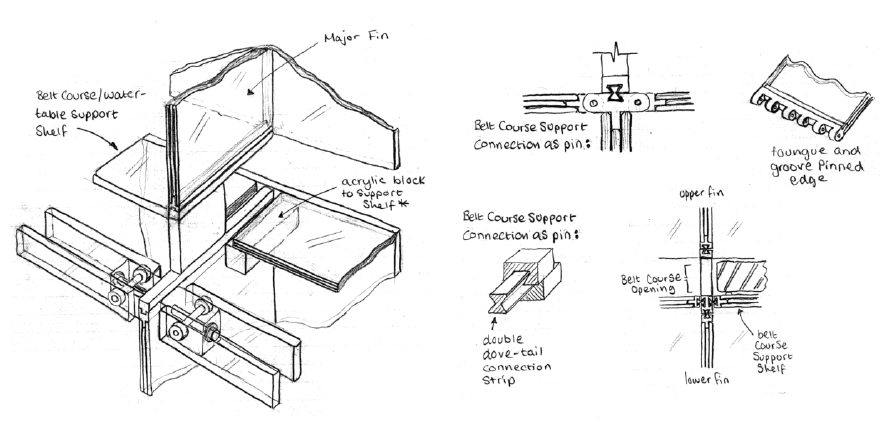
Figure 8: Stainless Steel Connection Junction at Floor Bearing Level.